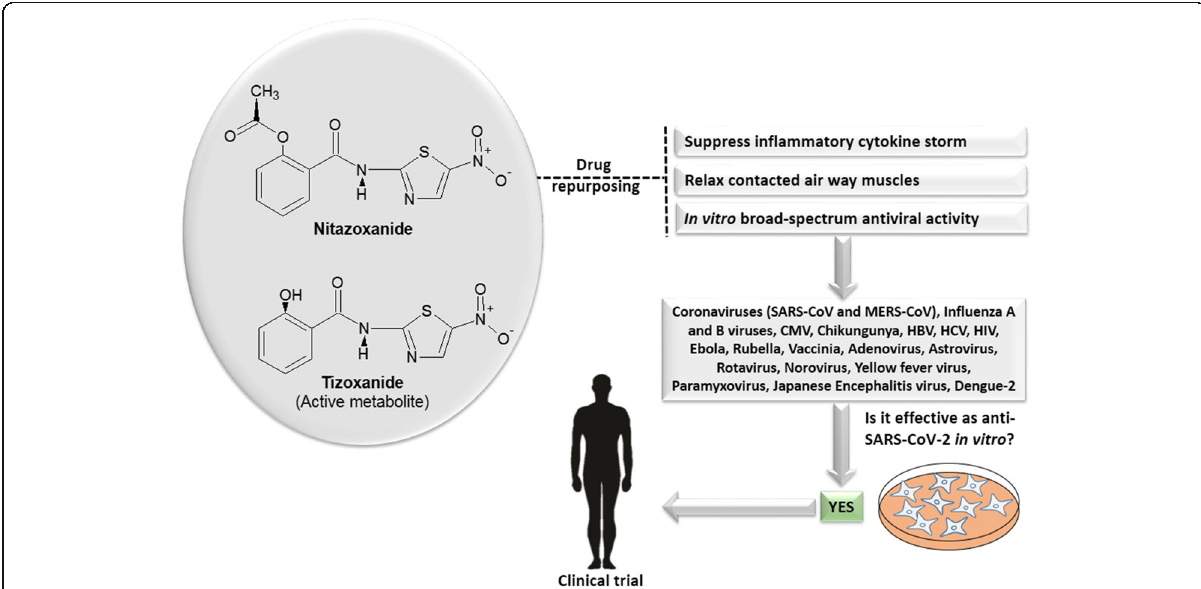
Fig. 1 Drug repurposing of nitazoxanide (NTZ) and its active metabolite tizoxanide (TIZ). NTZ represents a promising medication for clinical trial against COVID-19 due to its ability to control excessive inflammatory immune responses, its bronchodilator effect, and in vitro anti-SARS-CoV-2